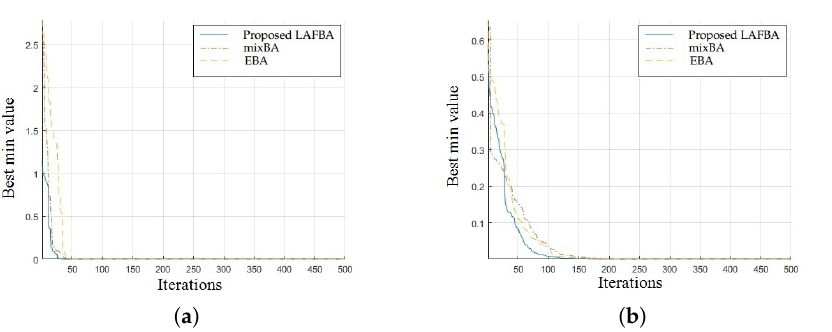
Figure 2. ( a ) Rotated hyperellipsoid convergence graph. ( b ) Griewank function convergence